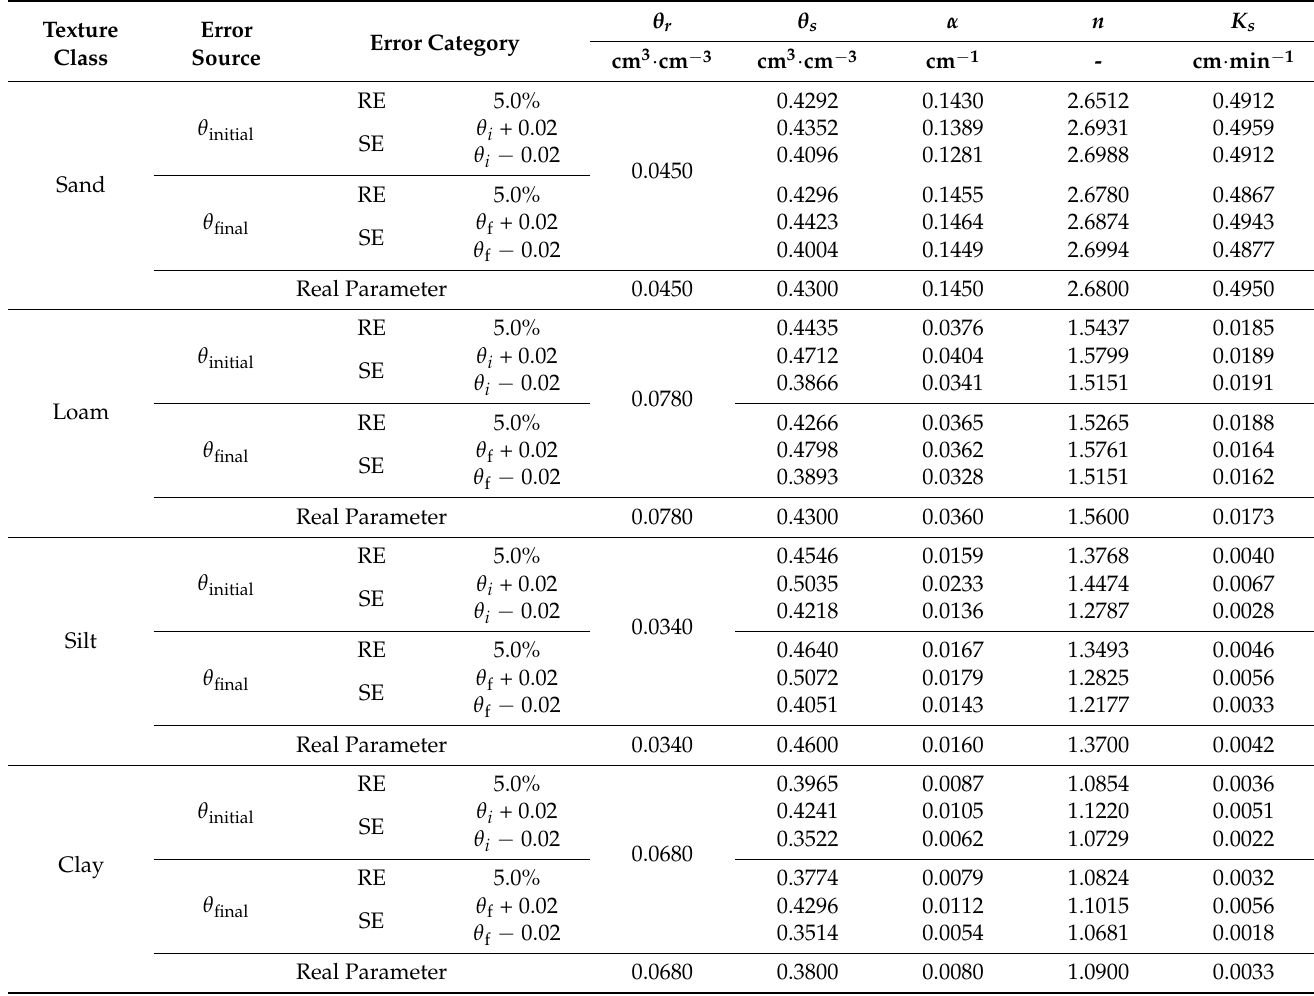
Table 5. Inverted parameters of both system and random errors in initial and final water content levels for the four typical soils.